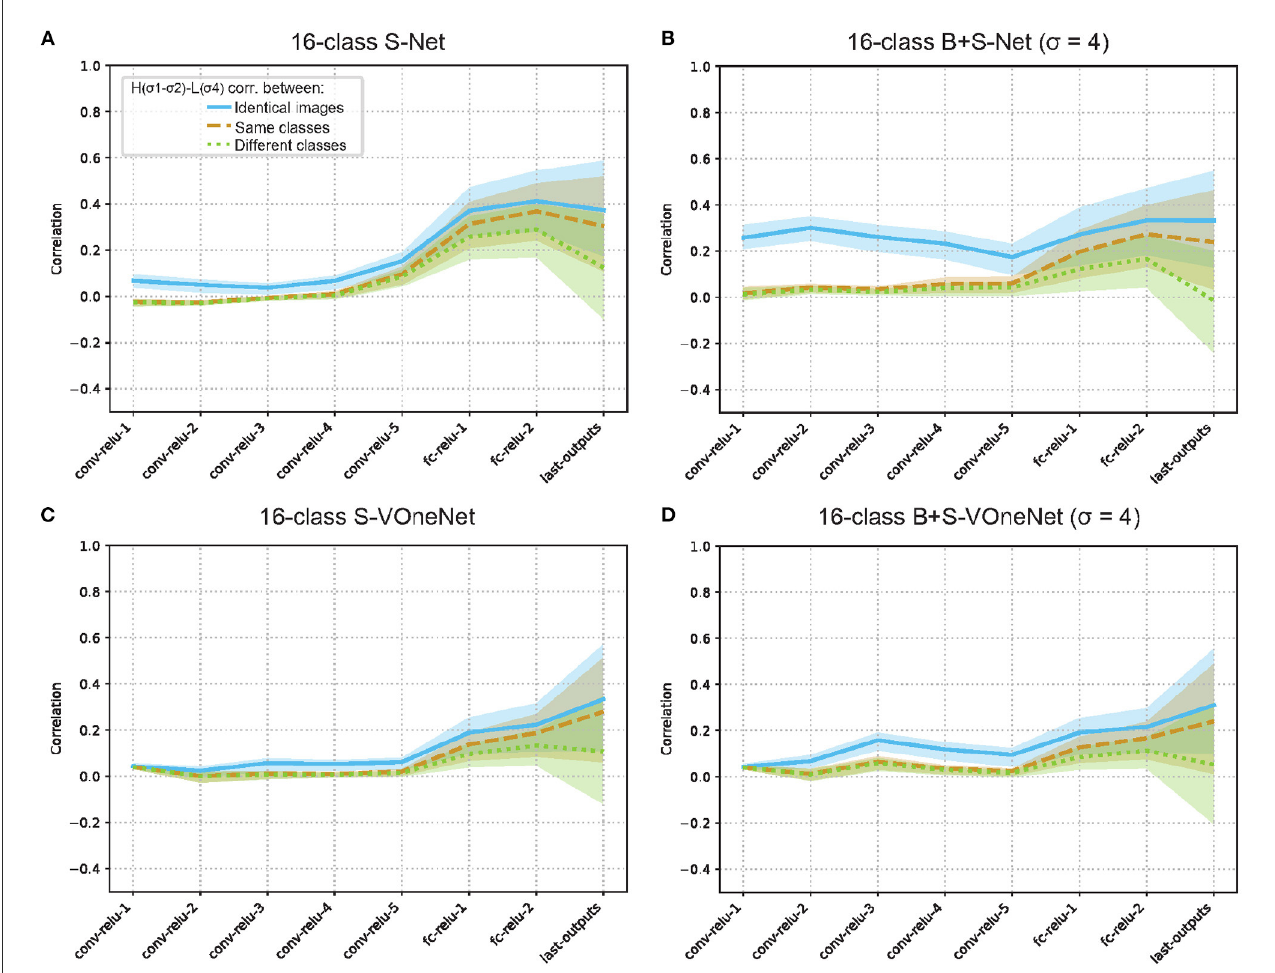
FIGURE8 Representational similarity of low-pass and high-pass image inputs for S-Net (A, C) and B+S Net (B, D) . 16-Class AlexNet (A, B) and VOneNet (C, D) . There is no evidence that blur training facilitates high-level frequency integration as found in human visual